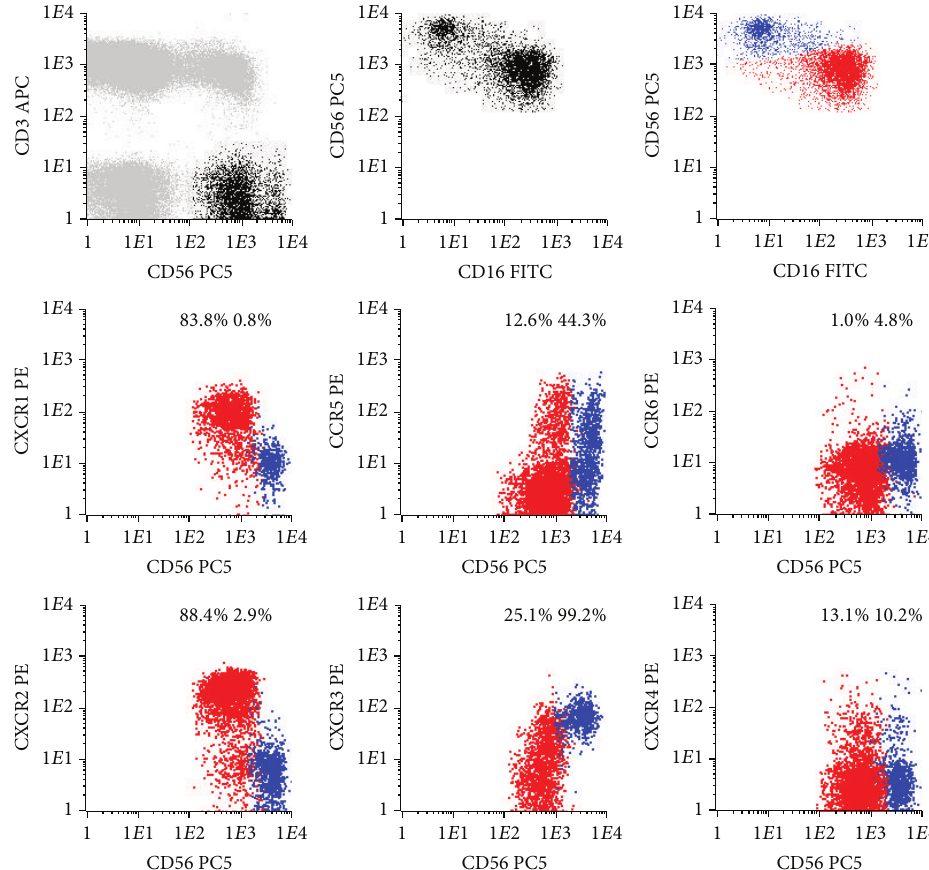
Figure 1: Representative dot plots illustrating the expression of different chemokine receptors (CKR) on the conventional CD 56 + low (red dots) and CD 56 + high (blue dots) NK-cell subsets present in the normal peripheral blood (PB). In order to obtain the dot plots showed in this figure, PB cells were stained with APC-conjugated anti-CD3, PC5-conjugated anti-CD56, PE-conjugated anti-CKR, and FITC-conjugated anti-CD16 monoclonal antibodies. Dot plots in the first row illustrate the strategy of gating. Using the CD3/CD56 dot plot, CD56 + NK-cells were first identified based on their CD3 − /CD56 + phenotype (black dots), comparatively to T (CD3 + ) and B (CD3 − CD56 − ) cells (gray dots). Then, after gating for CD56 + NK-cells (first CD56/CD16 dot plot), the CD 56 + low (red dots) and CD 56 + high (blue dots) NK-cell populations were identified based on their typical patterns of CD56 and CD16 expression (second CD56/CD16 dot plot). Finally, these NK-cell populations were analyzed for the expression of the CKR (CKR/CD56 dot plots). The numbers above the CD 56 + low and CD 56 + high NK-cells inside the CKR/CD56 dot plots indicate the percentage of cells staining positively for the correspondent CKR and were obtained after gating separately for each NK-cell population (CKR/CD56 dot plots gated for CD 56 + low and CD 56 + high NK-cells are not shown, for